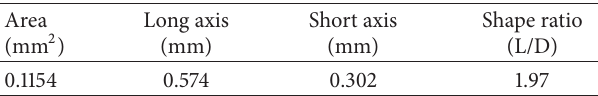
Table 1: Average geometrical dimensions of